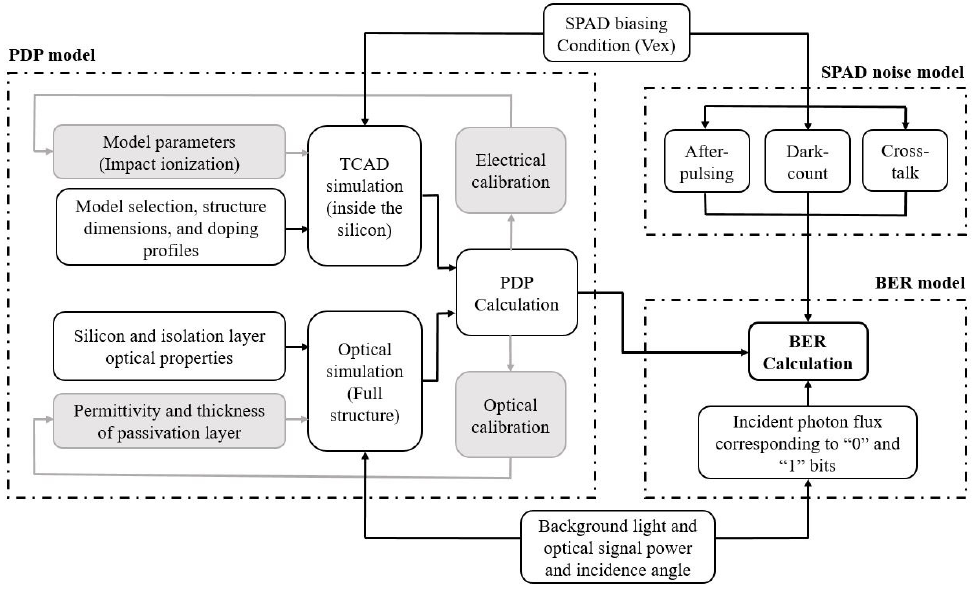
Figure 5. Flow chart of the extended BER model for accurate performance modeling of SPAD-based OWC receivers in presence of non-perpendicular light incidence (PDP model: [47], SPAD noise model: [44], BER model: [43]).